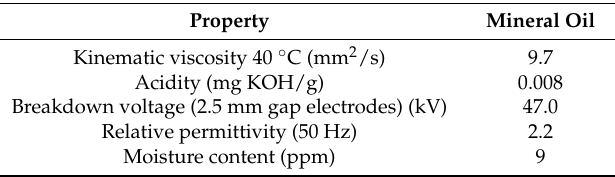
Table 2. The parameter of the oil used for impregnation.